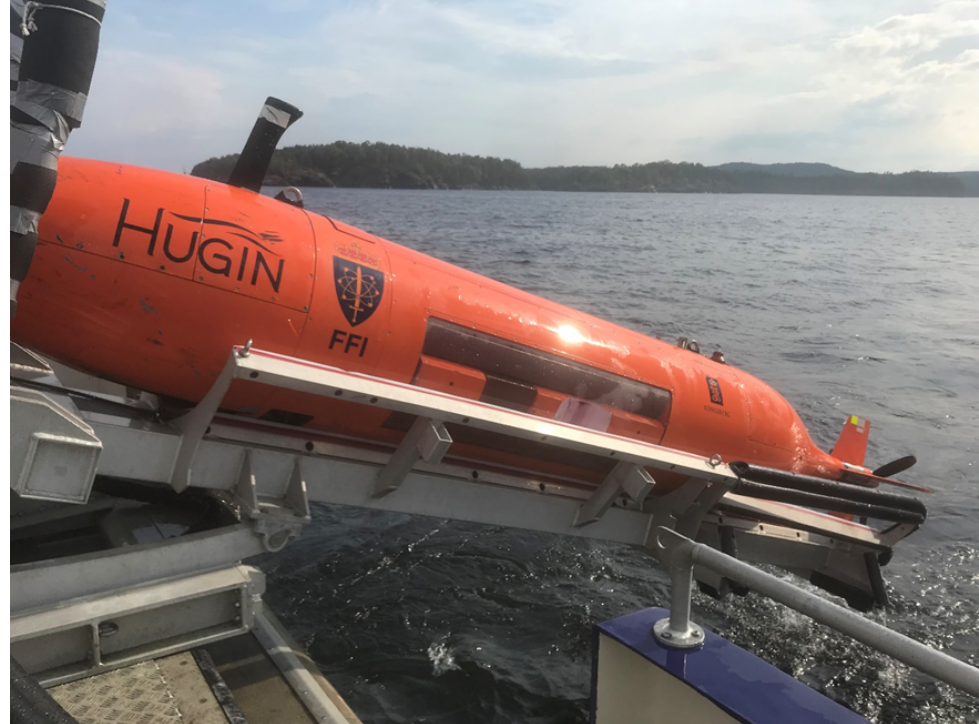
Figure 4. The HUGIN AUV equipped with a sensor payload including the HISAS system with capabilities for mapping the seabed and detecting gas seeps in the water column. This image was taken in Horten during the ACT4storage nearshore